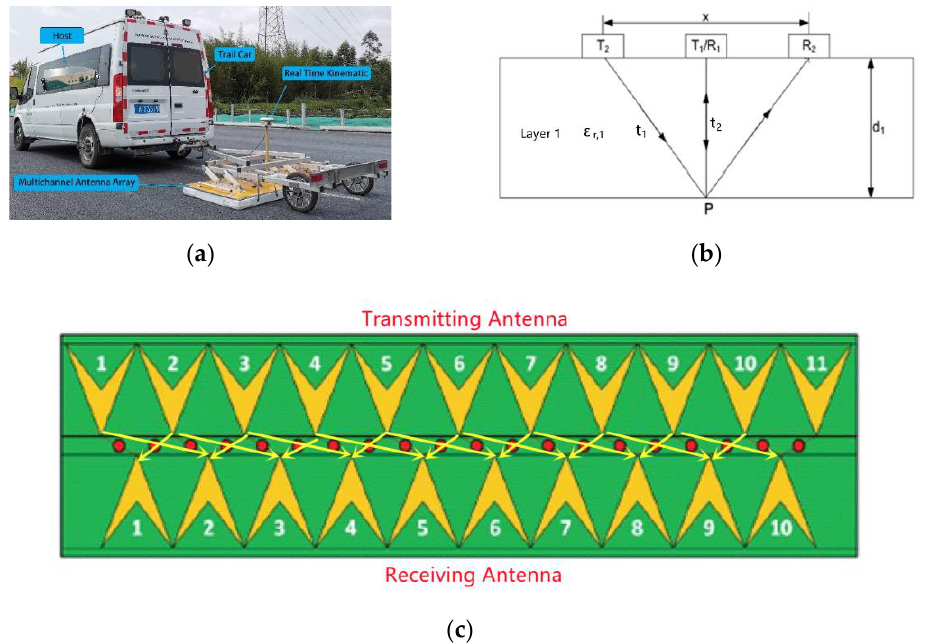
Figure 1. Onboard three-dimensional ground-penetrating radar system and detection principle. ( a ) Onboard three-dimensional ground-penetrating radar system. ( b ) Propagation model of electro- magnetic wave for dielectric constant detection. ( c ) Antenna combination configuration diagram.